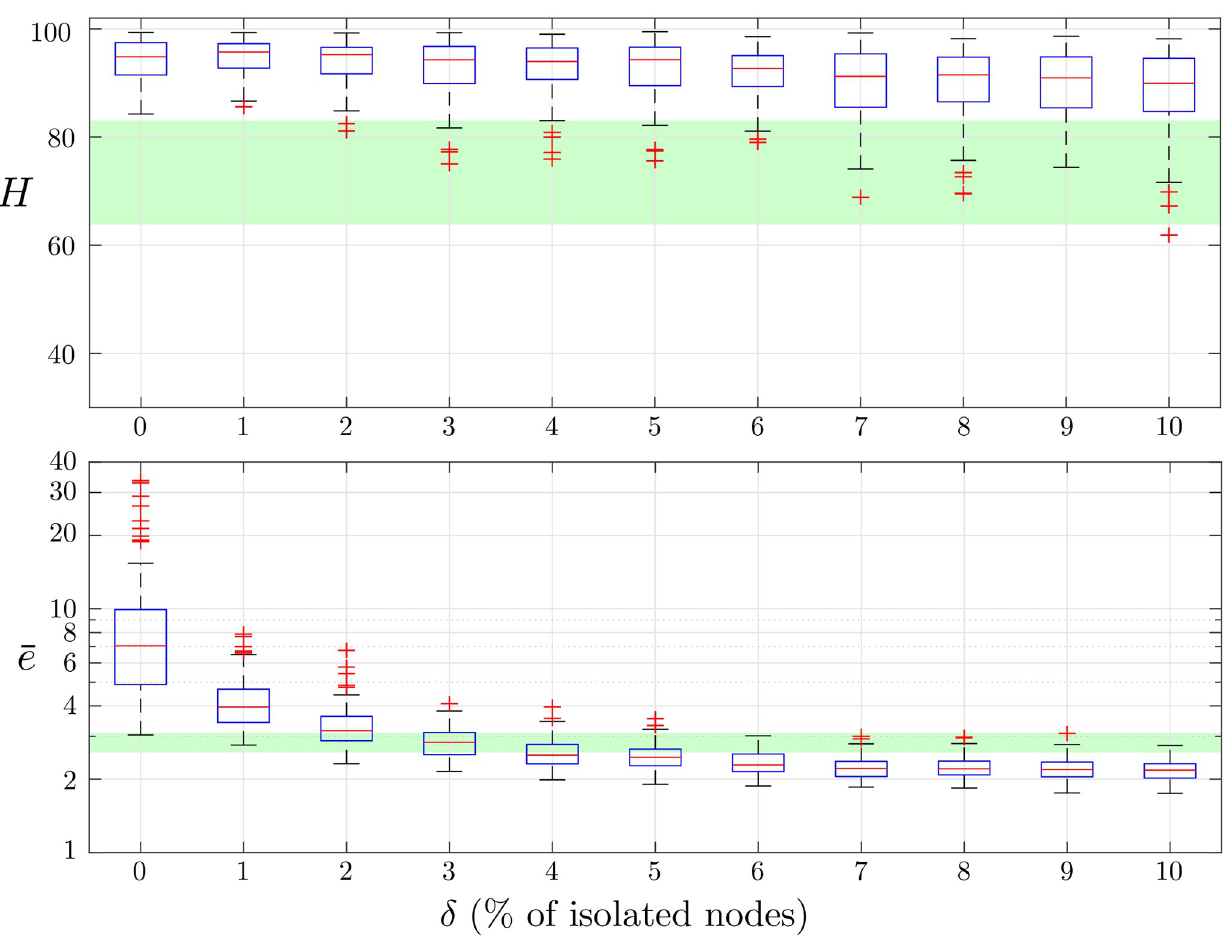
Fig 3. Box plots of the realizations of the herding intensity H (top panel) and the market efficiency � e (bottom panel) with 100 simulations for each value of δ . The green-shaded area corresponds to the box obtained for the case z = 0.